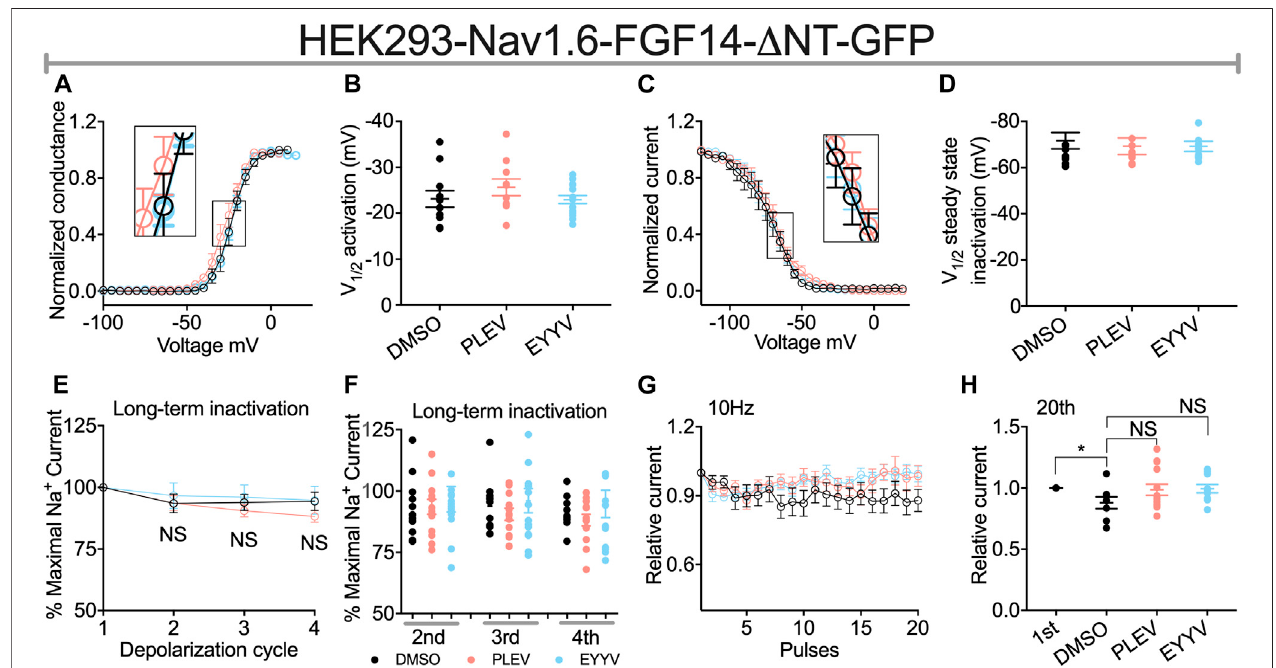
FIGURE 6 | The N-terminal domain of FGF14 is required for peptides to exert modulatory effects on Nav1.6 channel inactivation. (A) Conductance-voltage relationships for HEK293-Nav1.6 cells co-expressing FGF14- Δ NT-GFP treated with 0.1% DMSO, 50 µM PLEV and 50 µM EYYV. (B) Comparison of V1/2 of activation between the indicated experimental groups. (C) Normalized current as a function of membrane potential to characterize the effects of 0.1% DMSO, 50 µM PLEV and 50 µM EYYV on steady-state inactivation. (D) Comparison of V1/2 of steady-state inactivation between the indicated experimental groups. (E) Ratio maximal INa plotted as a function of depolarization cycle to characterize entry of Nav1.6 channels exposed to 0.1% DMSO, 50 µM PLEV, or 50 µM EYYV in the presence of FGF14- Δ NT.Cellsweresubjectedtofour0 mV16 msdepolarizationsseparatedby − 90 mV40 msrecoveryintervals. (F) Bargraphrepresented2nd,3rd,and 4thpulseofLTI. (G,H) AssessmentofcumulativeinactivationofNav1.6channelsexposedto0.1%DMSO,50 µMPLEV,or50 µMEYYVinthepresenceofFGF14- Δ NT.Itwasexamined by applying a 2 ms test pulse to − 10 mV 20 times at frequency10 Hz from a holding potential of − 80 mV. Data are mean ± SEM. Signi fi cance was assessed using an